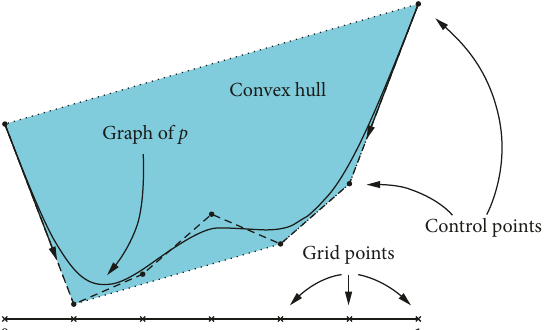
Figure 1: The curve of a univariate polynomial p , the colored convex hull of control points optimizes the polynomial curve, and the minimum Bernstein value approximates the minimum